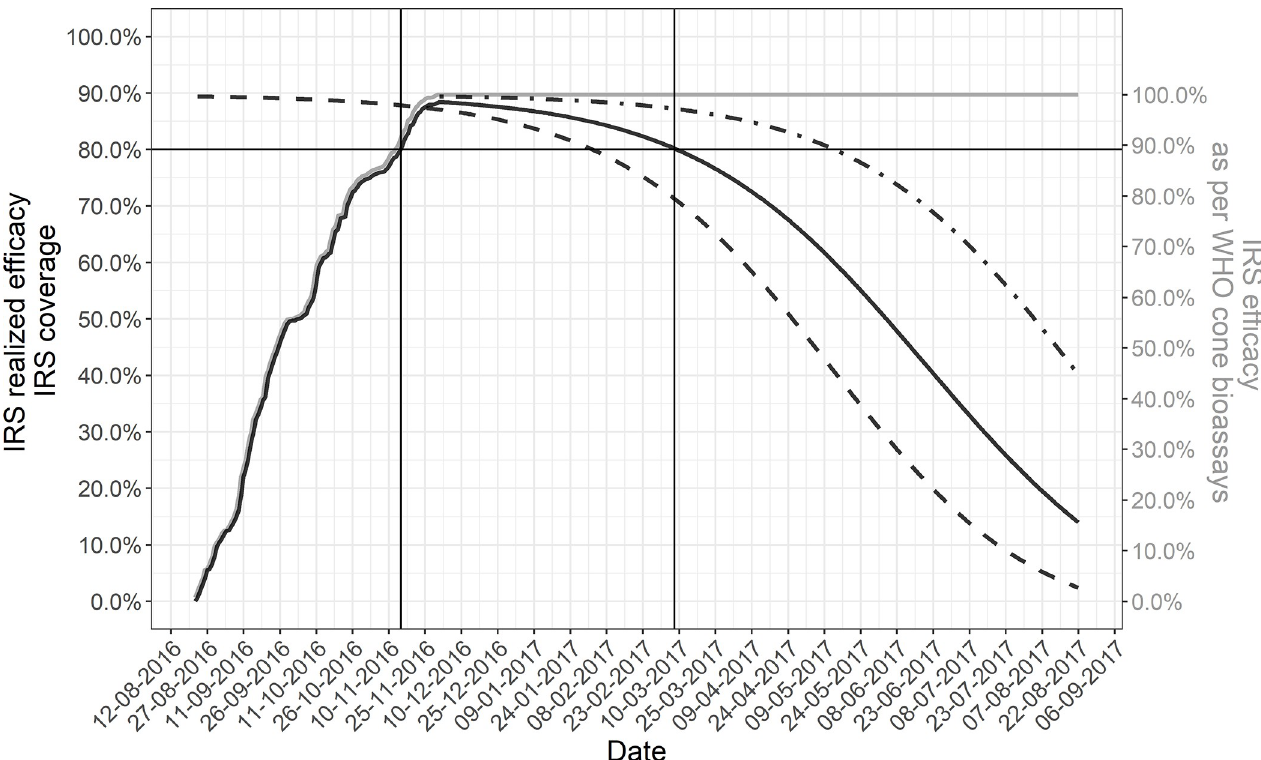
Fig 4. District-level IRS realized efficacy of the 2016 IRS campaign in Magude district. Grey solid line: IRS effective coverage (household level). Black solid line: Realized IRS residual efficacy in the district considering IRS coverage, the pace of spraying, residual efficacy in mud and cement walls and the distribution of these wall types in the district. To illustrate the effect of adjusting residual efficacy by pace of spraying, the dashed and dotted dashed lines represent how residual efficacy would have evolved if it started to decay at the beginning or the end of the campaign, respectively. Vertical lines mark the date when the campaign started to kill more than 80% of the mosquitoes resting indoors and when it started to kill less than 80%